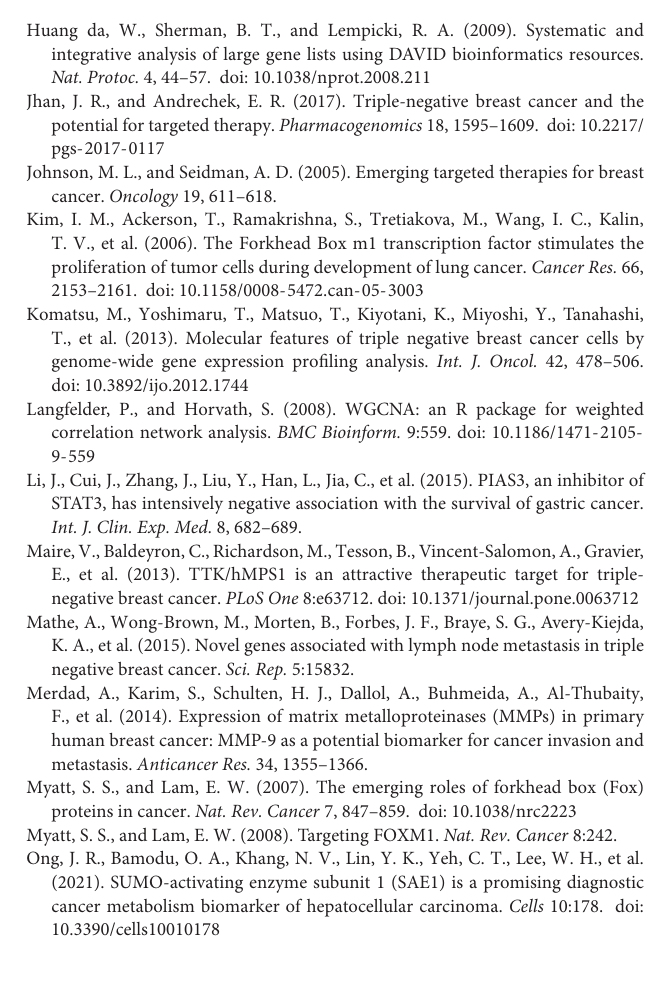
Supplementary Figure 1 | The mRNA expression of SAE1 in breast cancer. The mRNA expression of SAE1 in breast cancer patients based on GSE31448 (A) , GSE45827 (B) , and GSE65216 (C) . ns, p > 0.05; ∗ p < 0.05; ∗∗∗ p < 0.001. Supplementary Figure 2 | The pathway activity of SUMOylation in breast cancer. The pathway activity of SUMOylation in breast cancer based on GE21635. ns, p > 0.05; ∗ p < 0.05. Supplementary Figure 3 | The OS and DFS of protein SUMOlyation pathway for TNBC patients. The prognostic value of protein SUMOlyation pathway for OS (A) and DFS (B) in TNBC patients by Kaplan-Meier analysis. Supplementary Figure 4 | Forkhead box M1 (FOXM1) regulates the expression of SAE1. The expression of FOXM1 (A) and SAE1 (B) in breast cancer cells transfected with control or FOXM1 siRNA base on GSE55204. Correlation between SAE1 expression and FOXM1 expression. Supplementary Figure 5 | Forkhead box M1 (FOXM1) regulates the expression of SAE1. Another two representative IHC images of SAE1 protein expression in TNBC